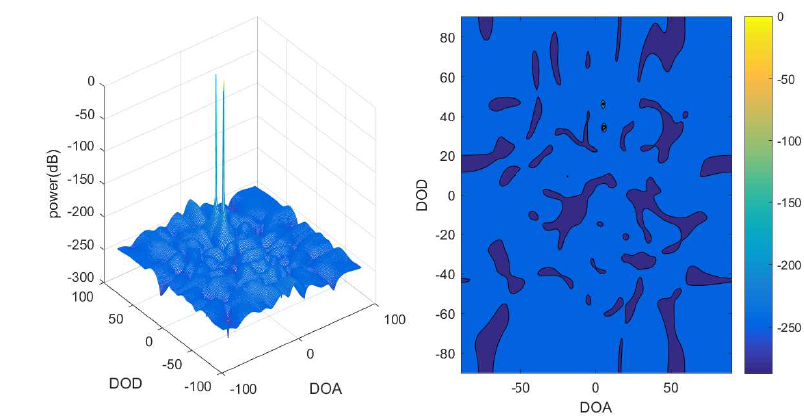
Figure 13. Spectrum of the bistatic data fitting DOD/DOA estimation algorithm, SNR = − 5 dB.